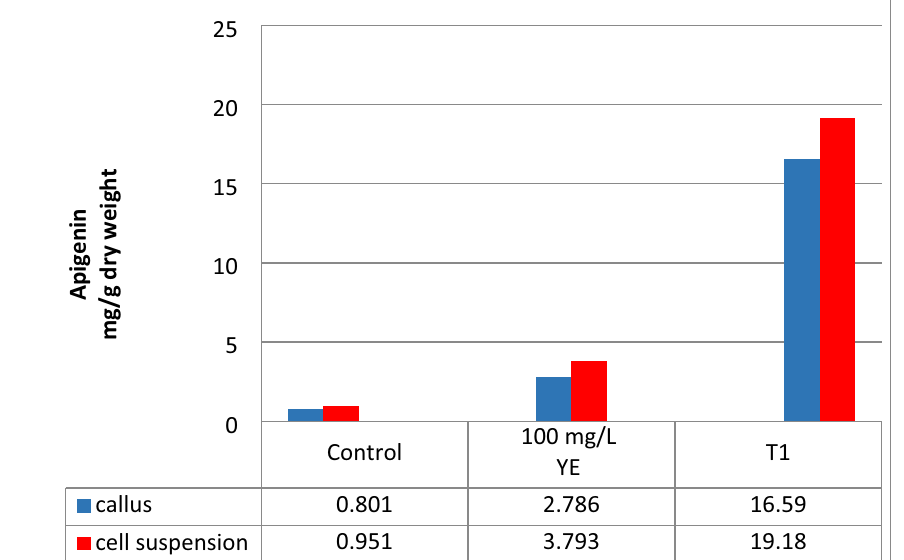
Figure 2. Apigenin contents in calli and cell suspension of the T 1 chiA -transgenic and the nontransgenic (control) A. trigonus measured by